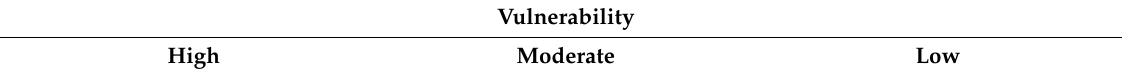
Table 1. Village typology based on socio-economic vulnerability levels and